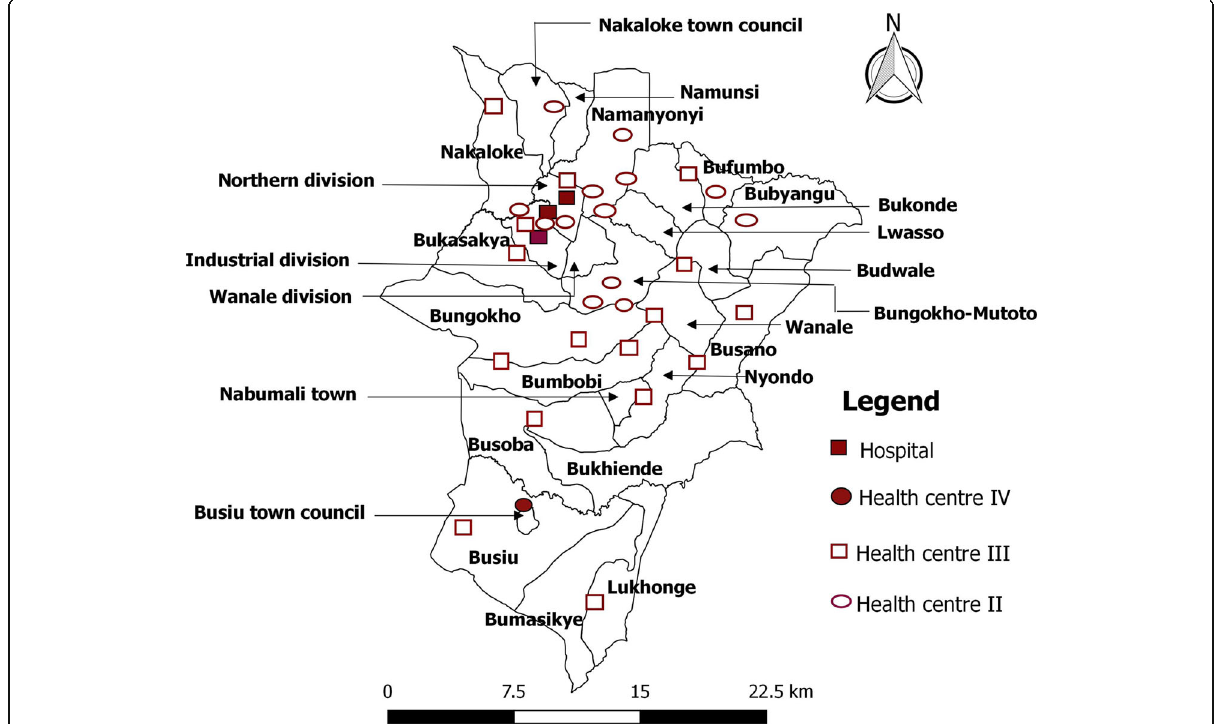
Fig. 2 Distribution of health facilities sampled in Mbale